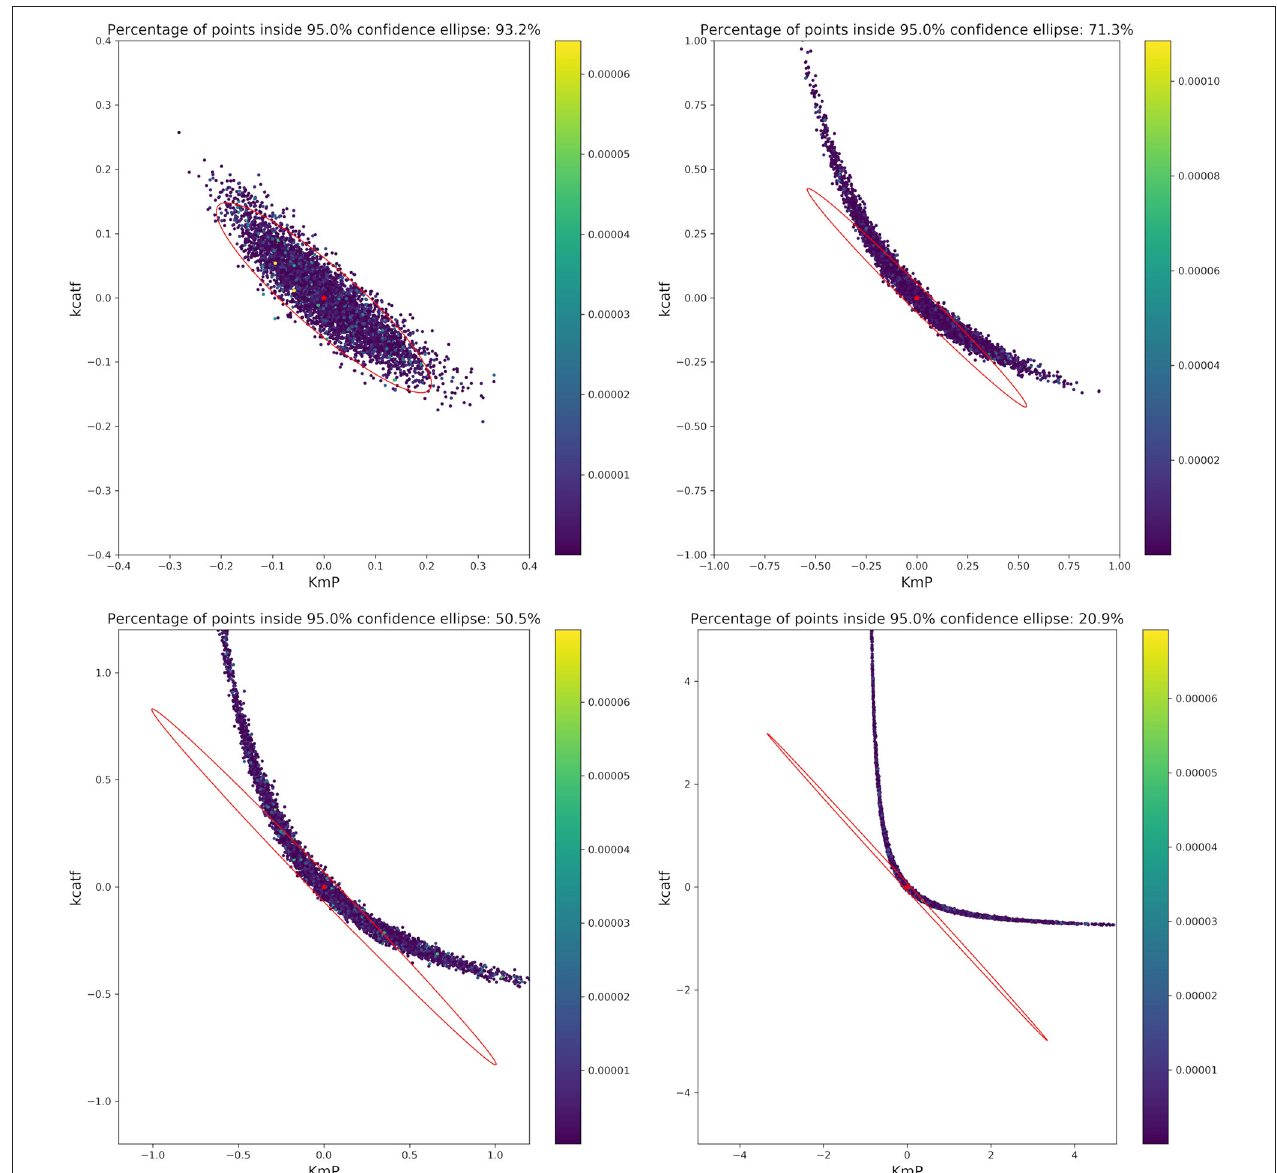
FIGURE 9 | Visualization of the FIM and results from Monte Carlo simulations for two parameters for 4 different sample times (Good, intermediate 1, intermediate 2, bad, from top right to bottom left). The color bar indicates the individual cost ( = LSQ) from that specific experiment. Especially for highly non-linear models, the FIM is a bad representation of the actual parameter